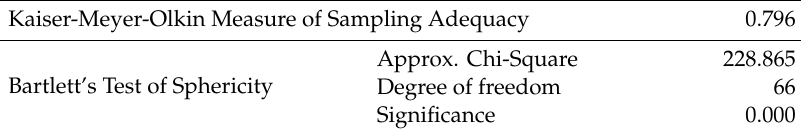
Table A1. Results of KMO and Bartlett’s Tests for the indicator of system usability.